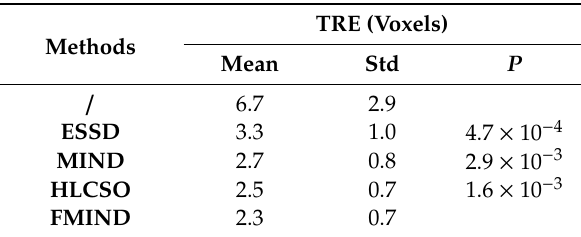
Table 3. The TRE for all evaluated methods and the P values for the t -test between the FMIND method and other compared methods operating on the three-dimensional CT-magnetic resonance (3D CT–MR) image